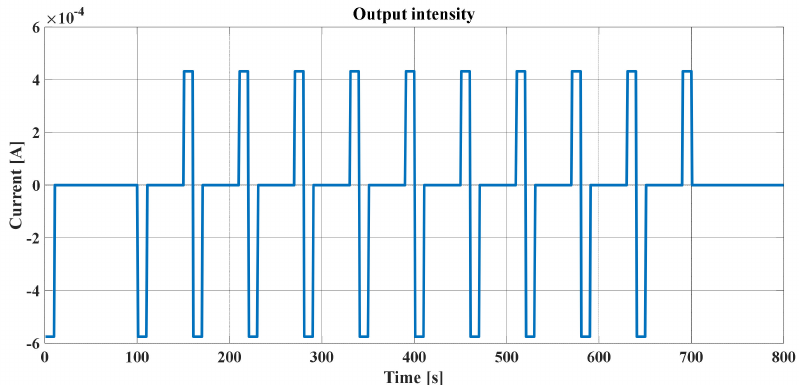
Figure 25. Vector of the current applied to the electrochemical cell.